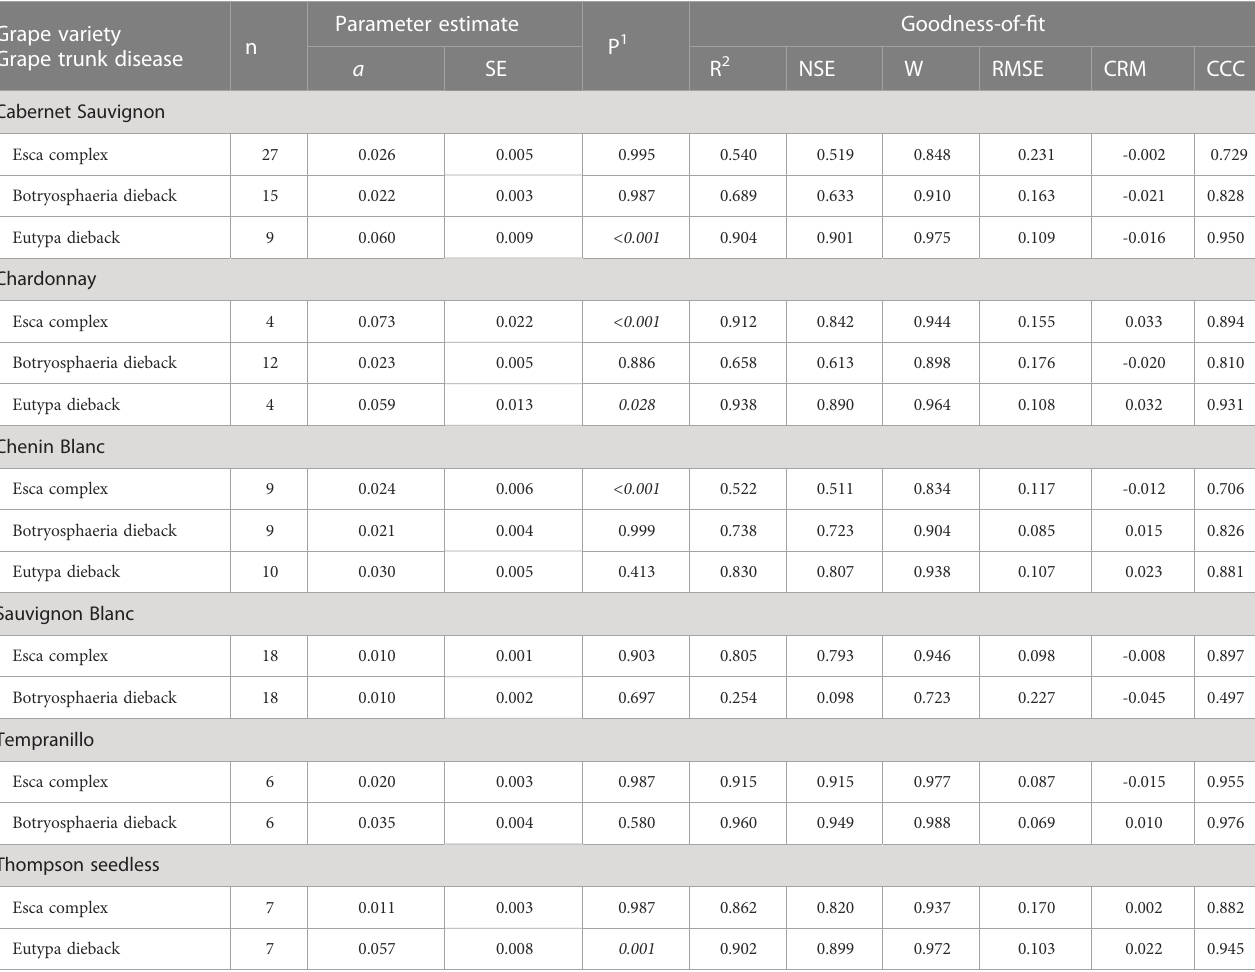
TABLE 4 Parameters and statistics of goodness-of- fi t for equation [1] (see text), which predicts pruning wound susceptibility as a function of time after pruning when wounds were inoculated for subsets of the data that concern the interaction between grape variety and grape trunk disease. Grape variety Grape trunk